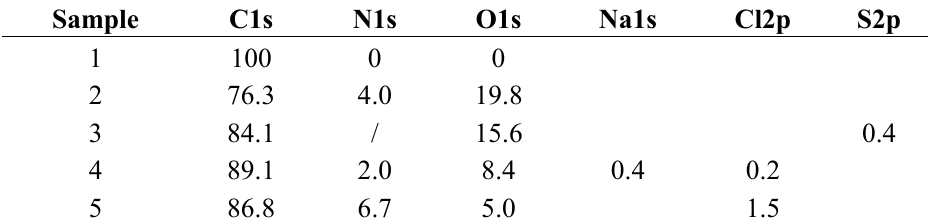
Table 2. Average surface composition of the LDPE samples as revealed by